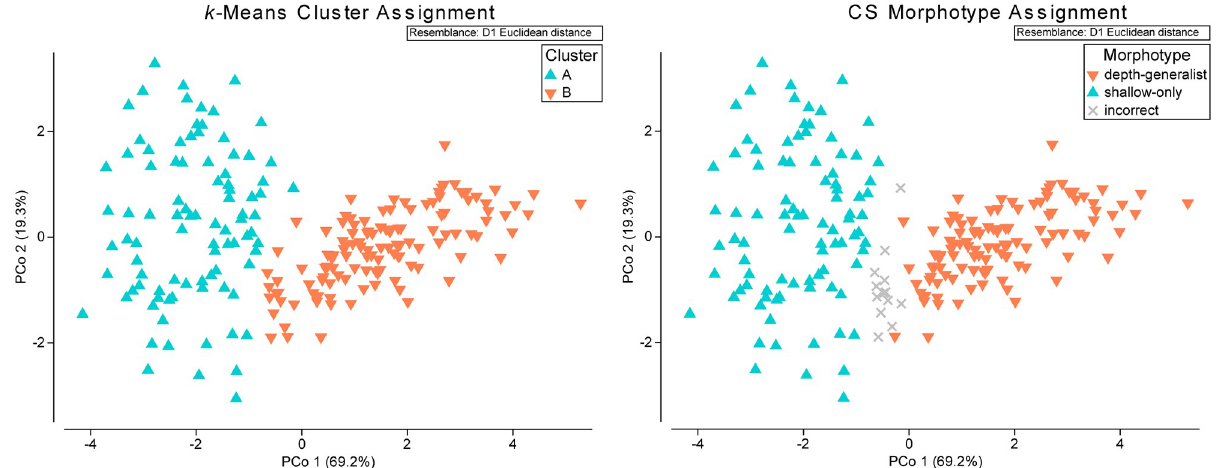
Fig 4. Comparison of morphotype assignment methods. Principal coordinates analyses (PCoA) of corallite morphology across six sites in the Gulf of Mexico, with color overlays corresponding to morphotypes. Morphotype assignments were made using a k -means cluster test (left; kRCLUSTER: R = 0.746) and by the threshold in corallite spacing measurements at 8.40 mm (right). Assignments using the corallite spacing method had a correct assignment rate of 93.87% when compared to assignments from the k -means clustering method (13 incorrect out of 212 assignments, shown in gray).